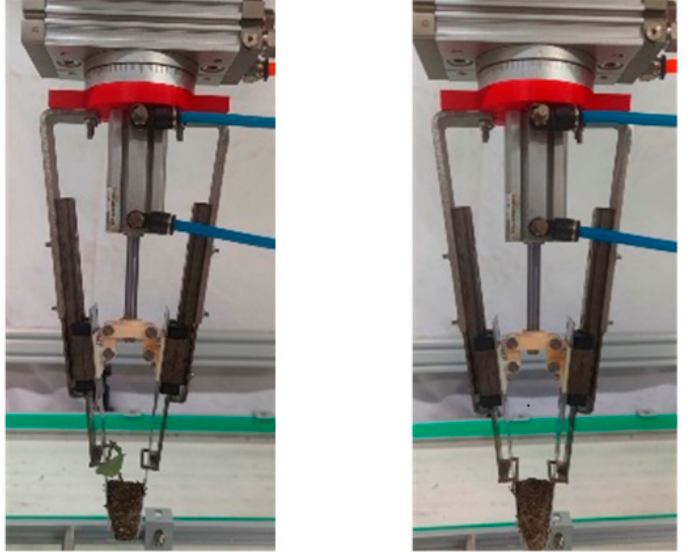
Figure 16. Transplanting process of the whole machine.